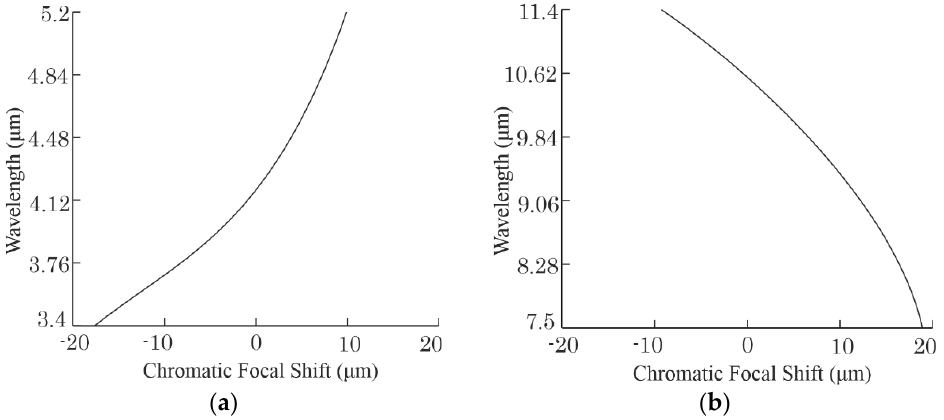
Figure 8. Chromatic focal shift for the refractive version of the objective: ( a ), in MWIR subrange; ( b ), in LWIR subrange.